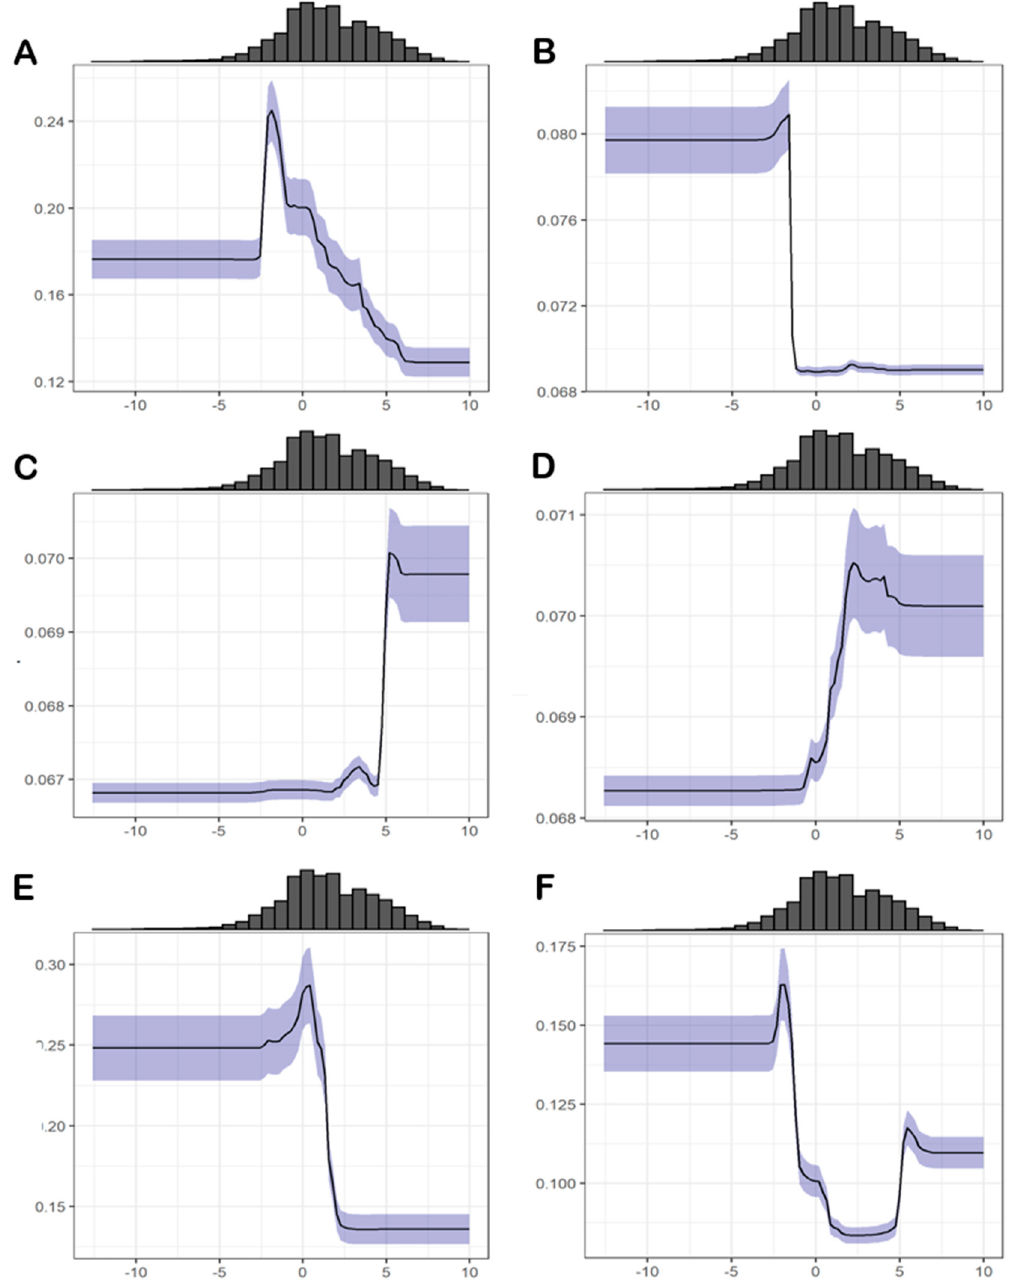
Figure A2. Response curves (average of all GBM models ± ½ std.-deviation) showing habitat suitability variation as function of the temperature of the coldest month (bio 6), for ( A ) MSD, ( B ) PRC, ( C ) T . lusitanica , ( D ) T . ebejeri , ( E ) T . semiaptera and ( F ) T . iberica .